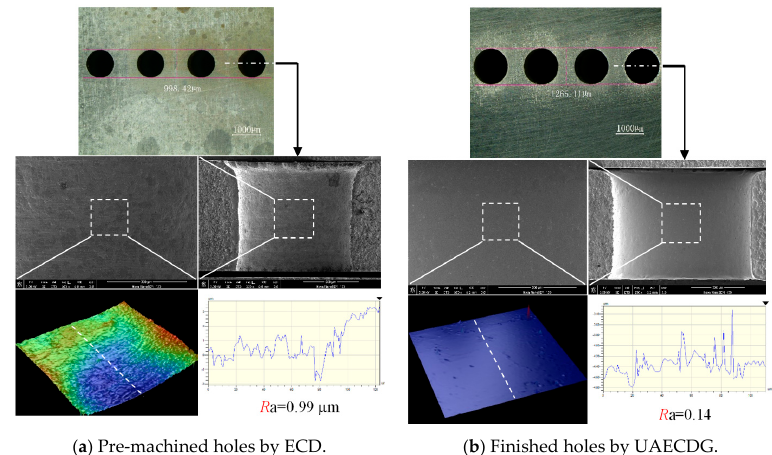
Figure 14. Pre-machined hole by ECD and finished holes by UAECDG.